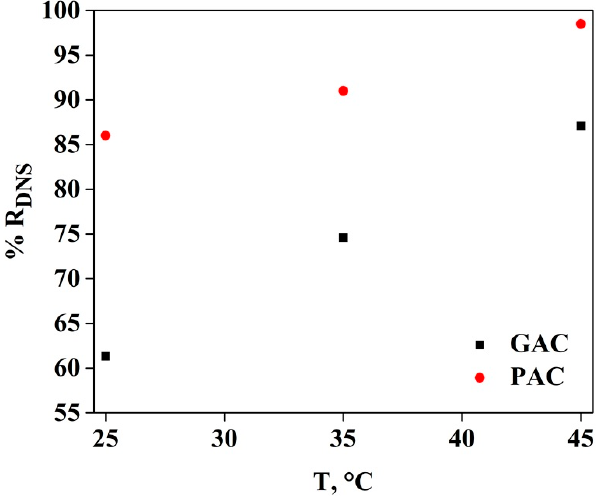
Figure 2. Influence of temperature on the percentage of removal of DNS in AC.